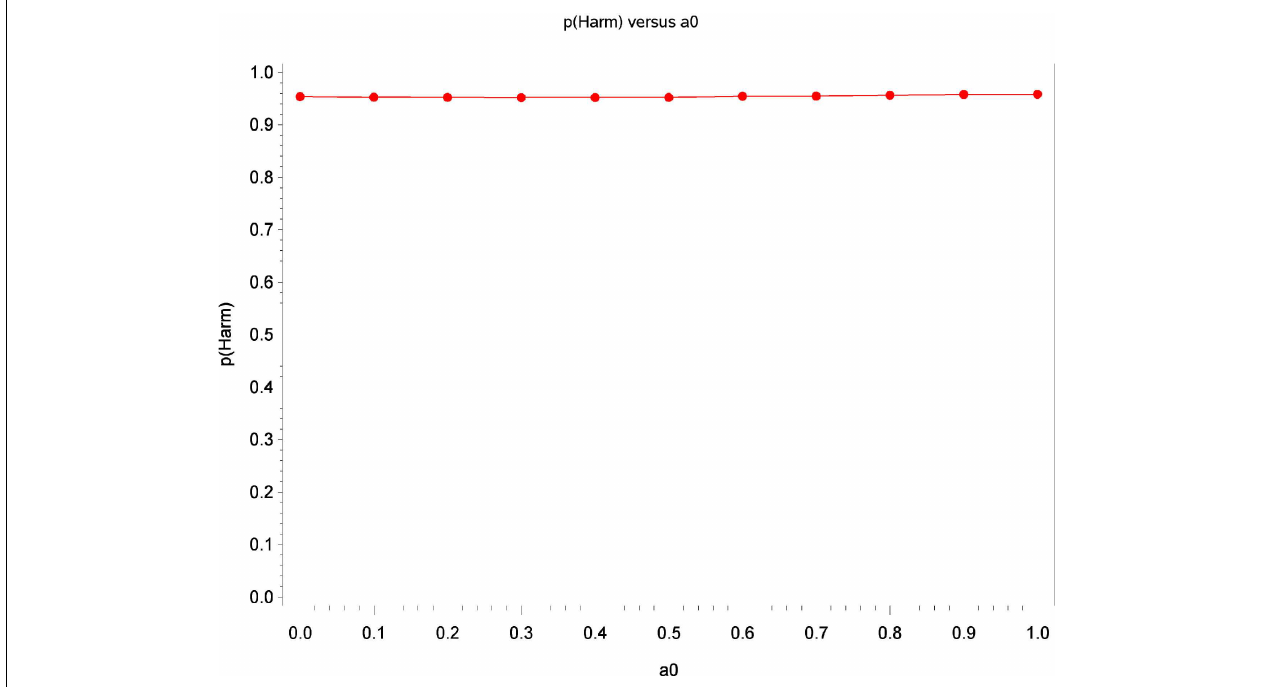
FIGURE 2 | Estimates of the probability that increased baseline marijuana use predicts decreasedTES scores in the levodopa treatment as a function of a 0 .